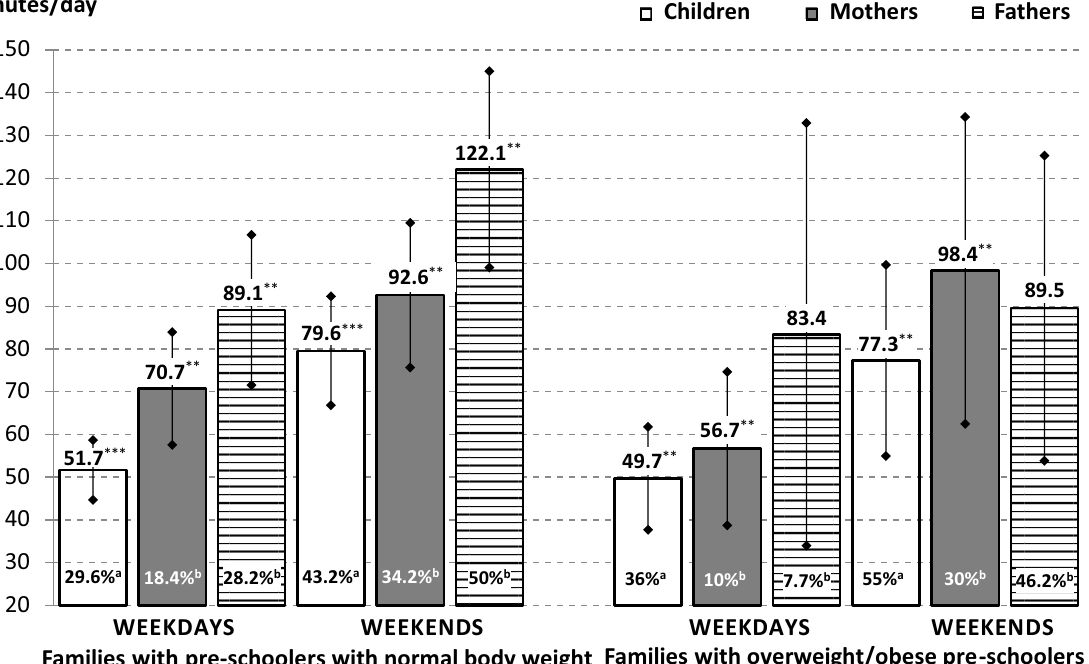
Figure 2. Comparison of parents’ and children’s logged daily screen time (mean and 95% confidence inter- vals) on weekdays and at weekends. % a = percentages of children who exceeded 1 hour of screen time per day; % b = percentages of mothers/fathers who exceeded 2 hours of screen time per day. The statistical significance of weekday-weekend differences in daily screen time is expressed as ** p ≤ .01, *** p ≤